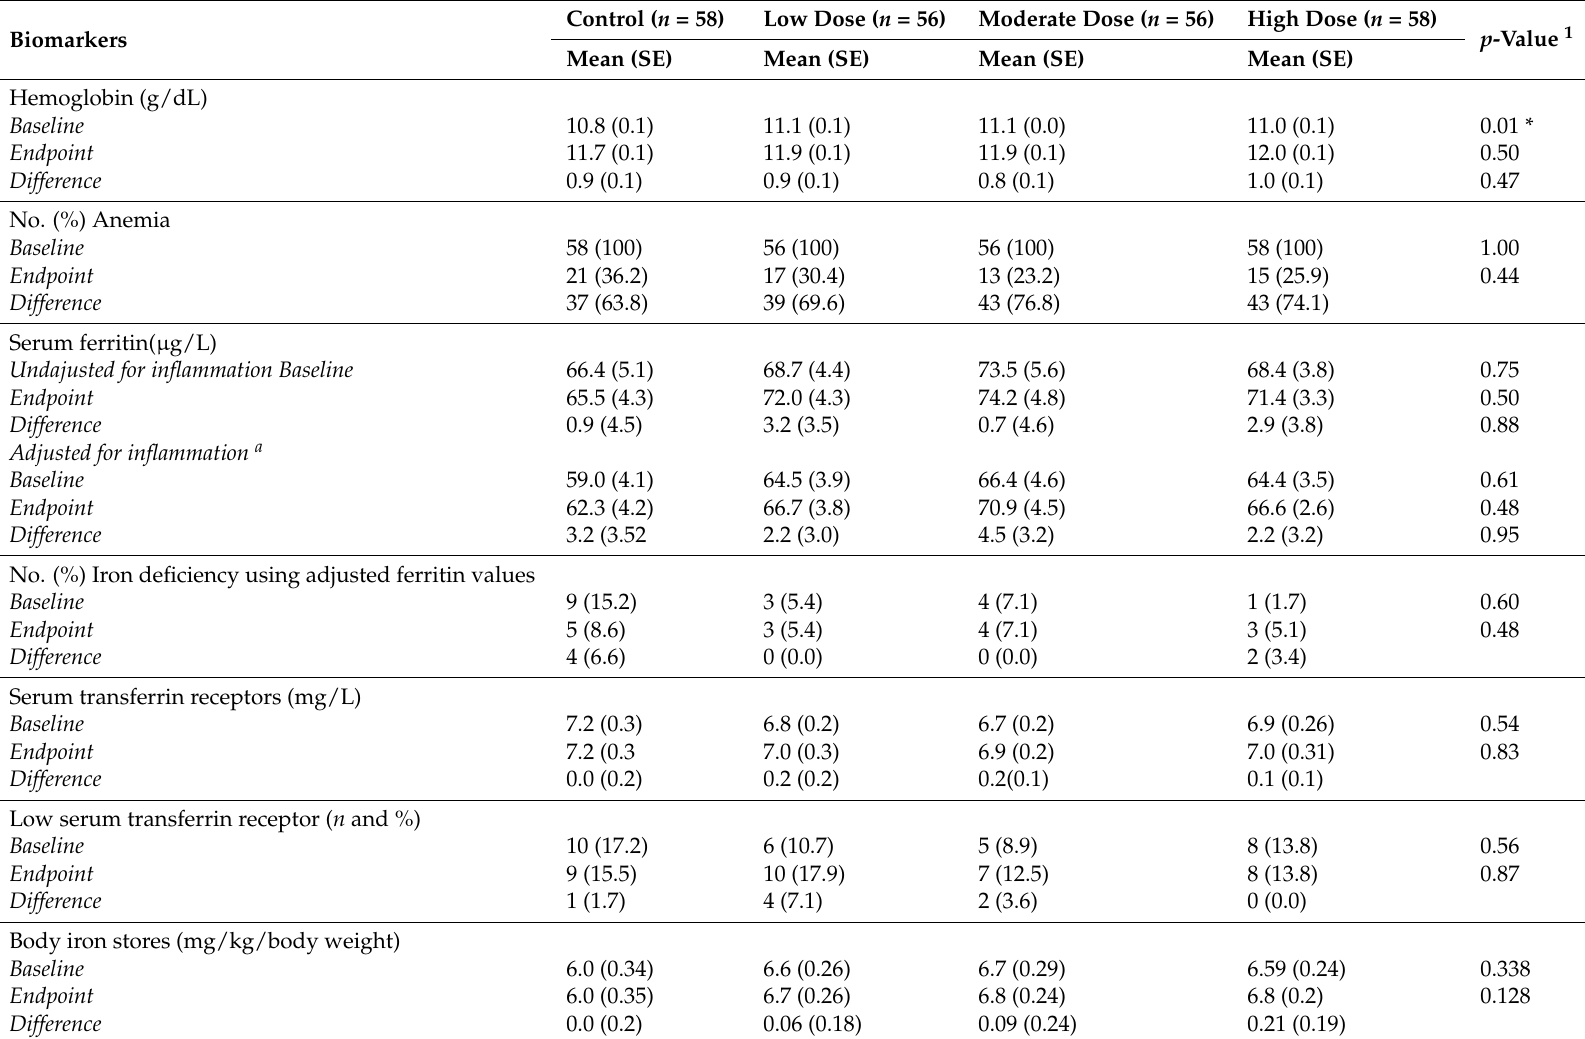
Table 3. Mean values and percent distribution of iron biomarkers of schoolchildren by group by